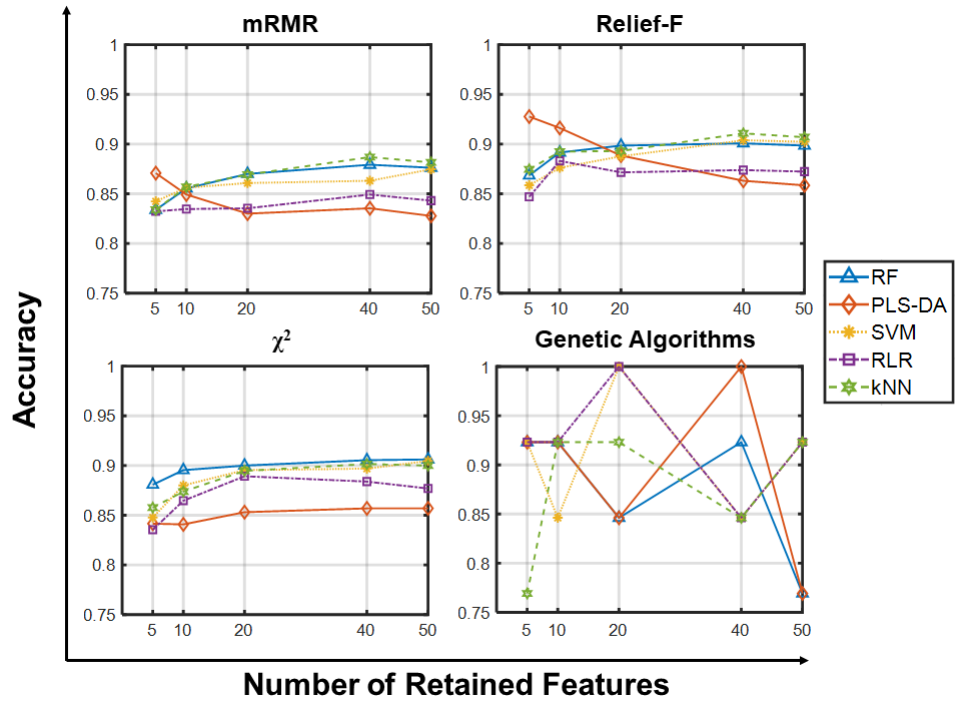
Figure 3. Predictive accuracy using few retained features on GLI_85. Predictive accuracies of the classifiers (RF, PLS-DA, SVM, RLR, kNN) vs. Number of Retained Features (5, 10, 20, 40, 50) on the GLI_85 dataset using the four feature selection methods. Each point in panels for mRMR, Relief-F and Chi-squared is the average predictive accuracy computed over 100 resamplings, while those for GA corresponds to a single value.